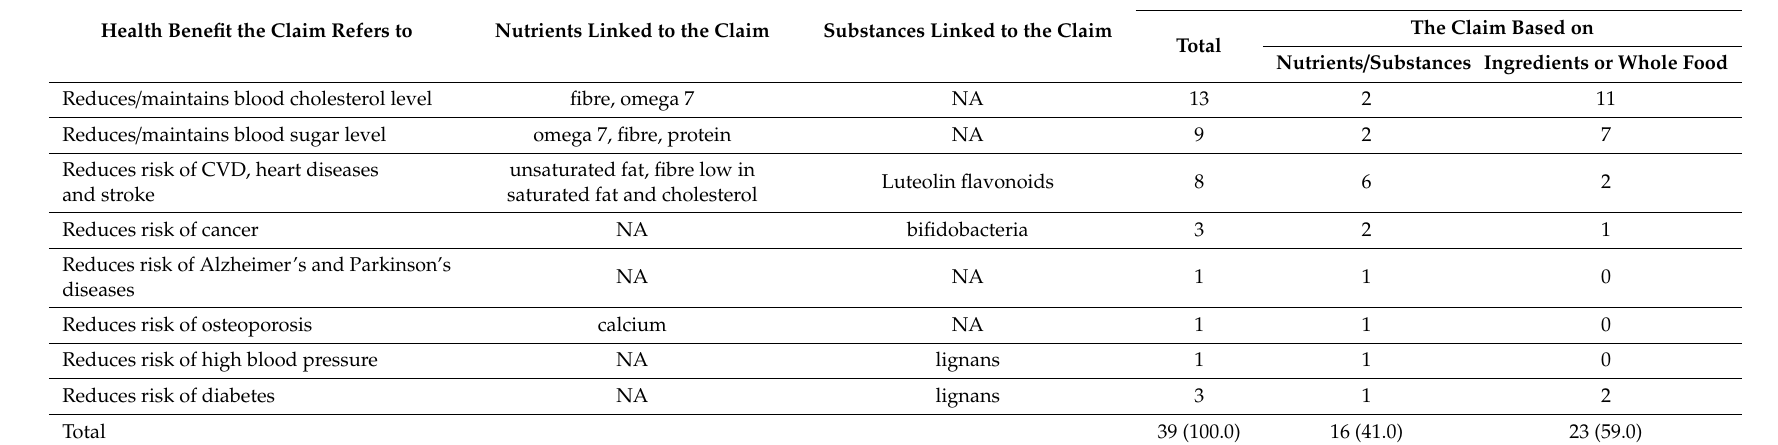
Table A5. Reduction of disease risk claims by attributable health